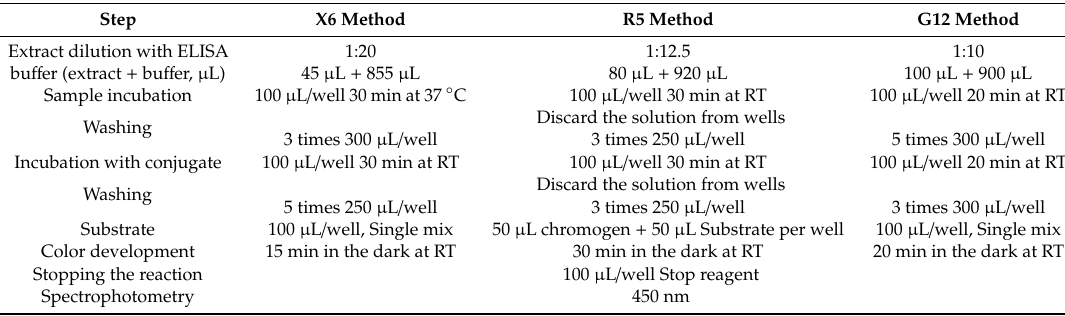
Table 2. ELISA procedures.